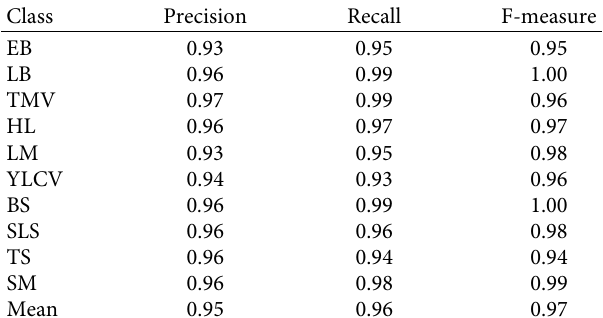
Figure 5: Using Adam optimizer, accuracy, and loss changing obtained using training and validation sets. Table 5: Performance reported in the form of P r , R c , and F m for the proposed model.